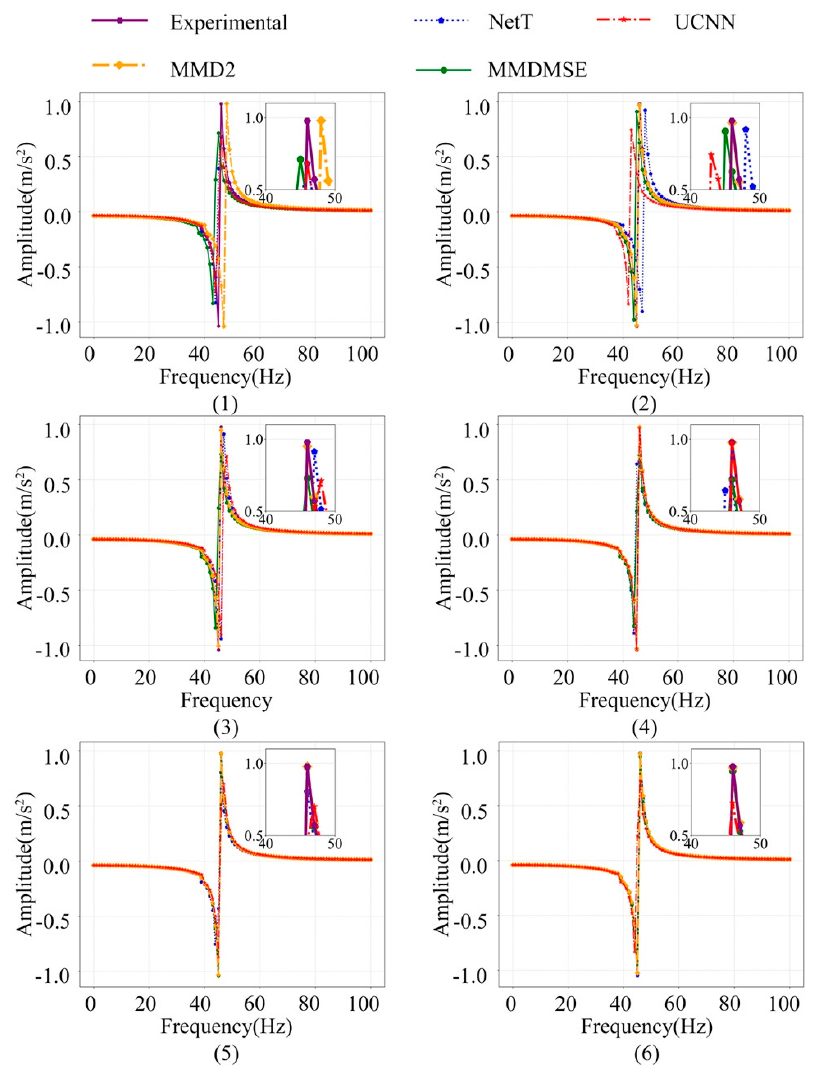
Figure 8. The FR signal of the No.1 sampling location at the X orientation sampling location with an increasing number of training samples ((1)–(6) represent for 100, 200, 500, 1000, 2000, 4000 samples).